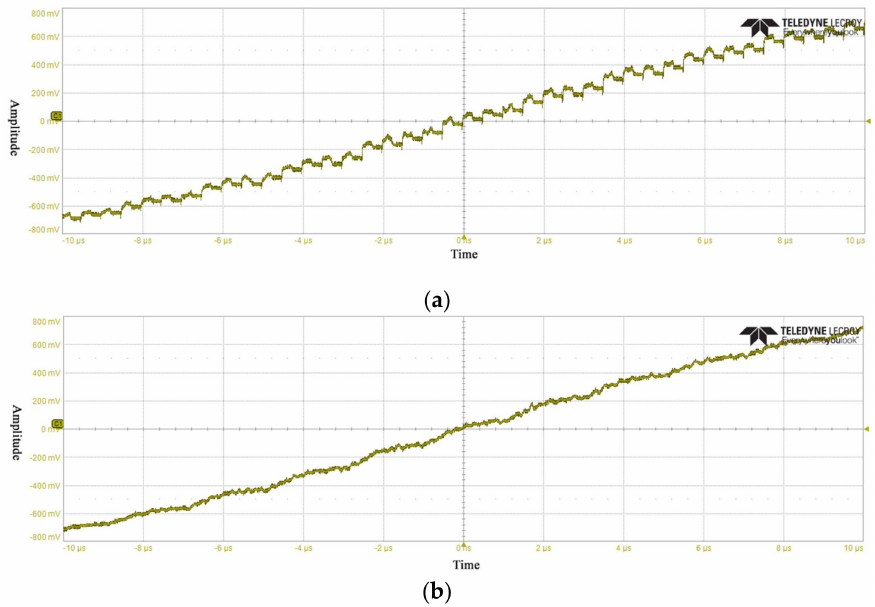
Figure 8. Output waveform after channel switching. ( a ) The amplitude is not calibrated. ( b ) After the amplitude is